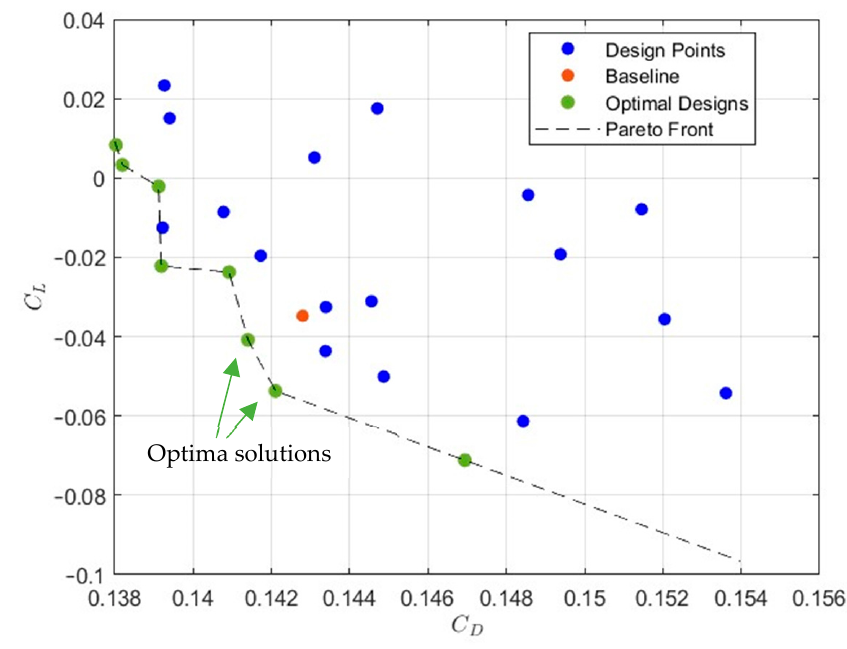
Figure 6. Solution of the multi − objective ASMO optimization.